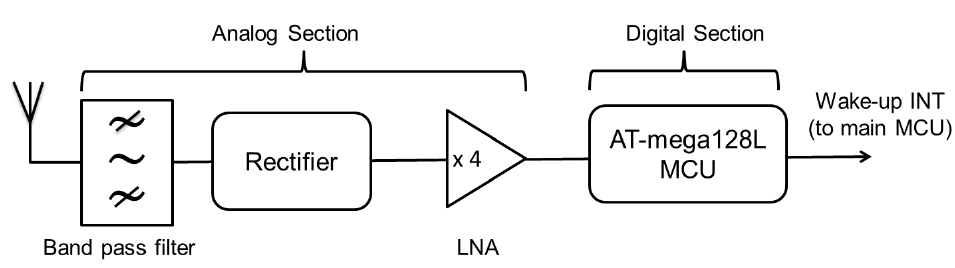
Figure 16. Employing a MCU in a WuRx